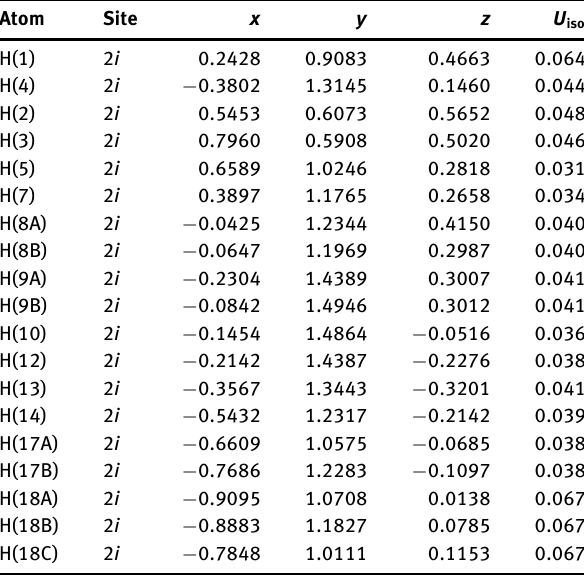
Table 2: Fractional atomic coordinates and isotropic or equivalent isotropic displacement parameters (Å 2